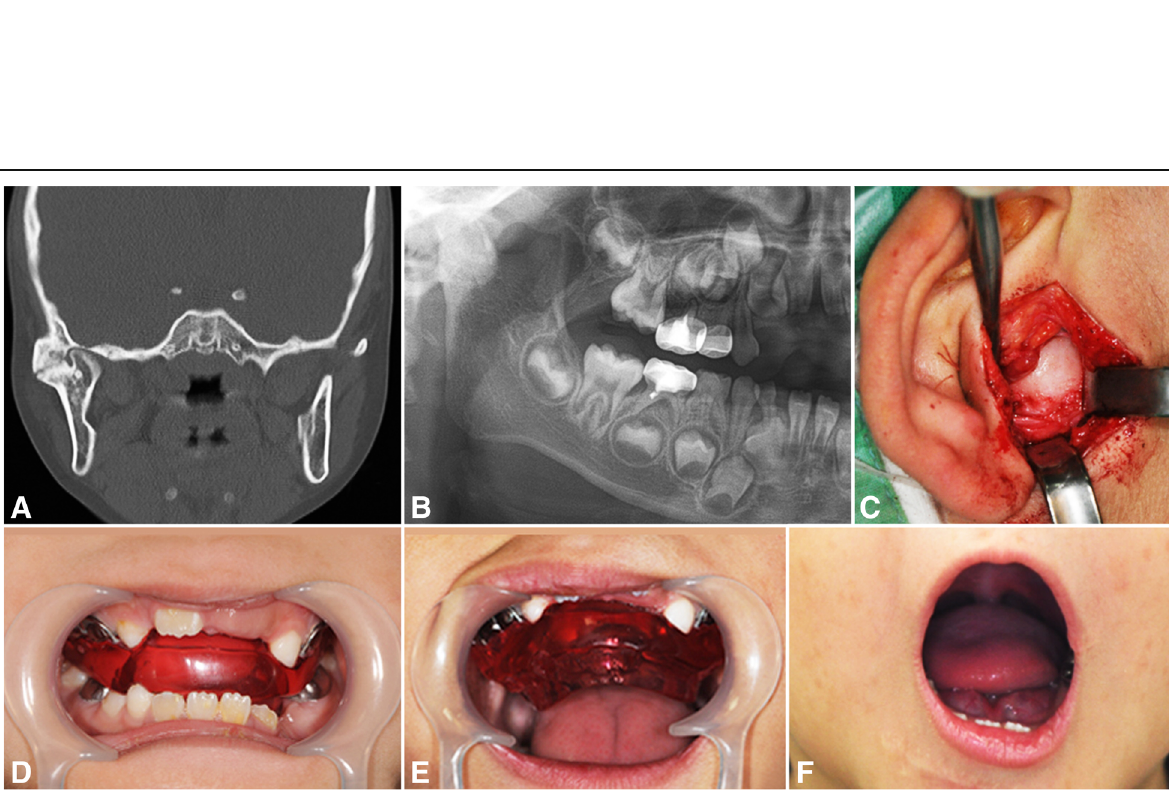
Fig. 3 A 6-year-old boy, right side TMJ bony ankylosis secondary to trauma, showing right TMJ ankylosis with medial dislocation of fractured condyle in coronal CT scan ( a ), preoperative panoramic view ( b ), endaural approach ( c ), interocclusal splint retained on the upper teeth ( d ), active mouth opening exercise with maximal interincisal opening ( e ), and mouth opening appearance after 7 years ( f